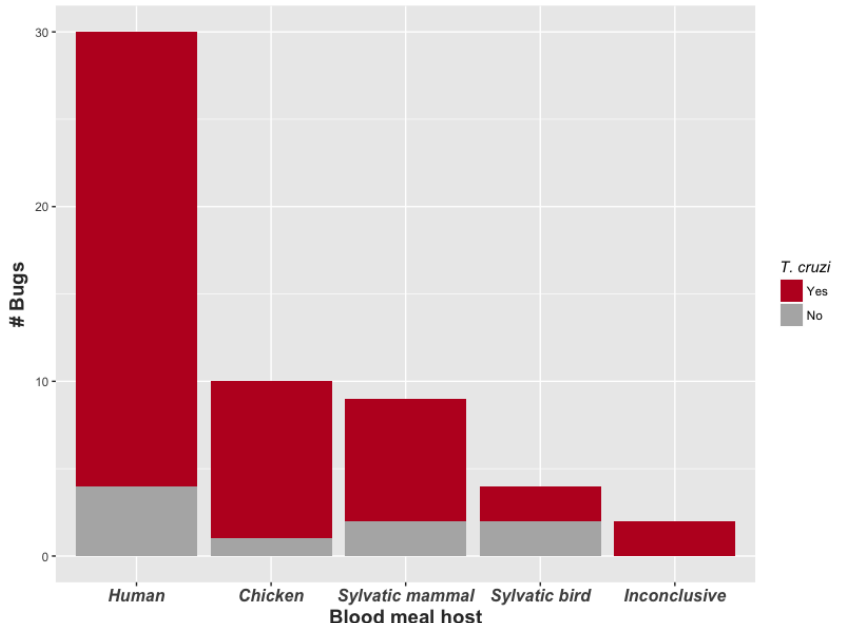
Figure 4. Number of bugs (i.e., blood meals) by blood meal host category and T. cruzi infection status of triatomine bug. Data were pooled across sites. One blood meal host was identified per bug. All triatomine species were adult P. geniculatus except for one adult male R. pictipes , which was infected with T. cruzi , and contained a human blood meal. Blood meal host species information is found in Table 2. Table 2. Blood Meal Species Identified in Triatomine Bugs Collected, and T. cruzi Infection Status of the Bug or Bugs Corresponding to Each Species. All Data Are Available in File S1, Including Accession Numbers and Sequences.